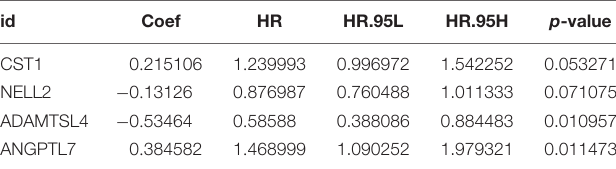
TABLE 3 | The ECM gene model information of ESCC.